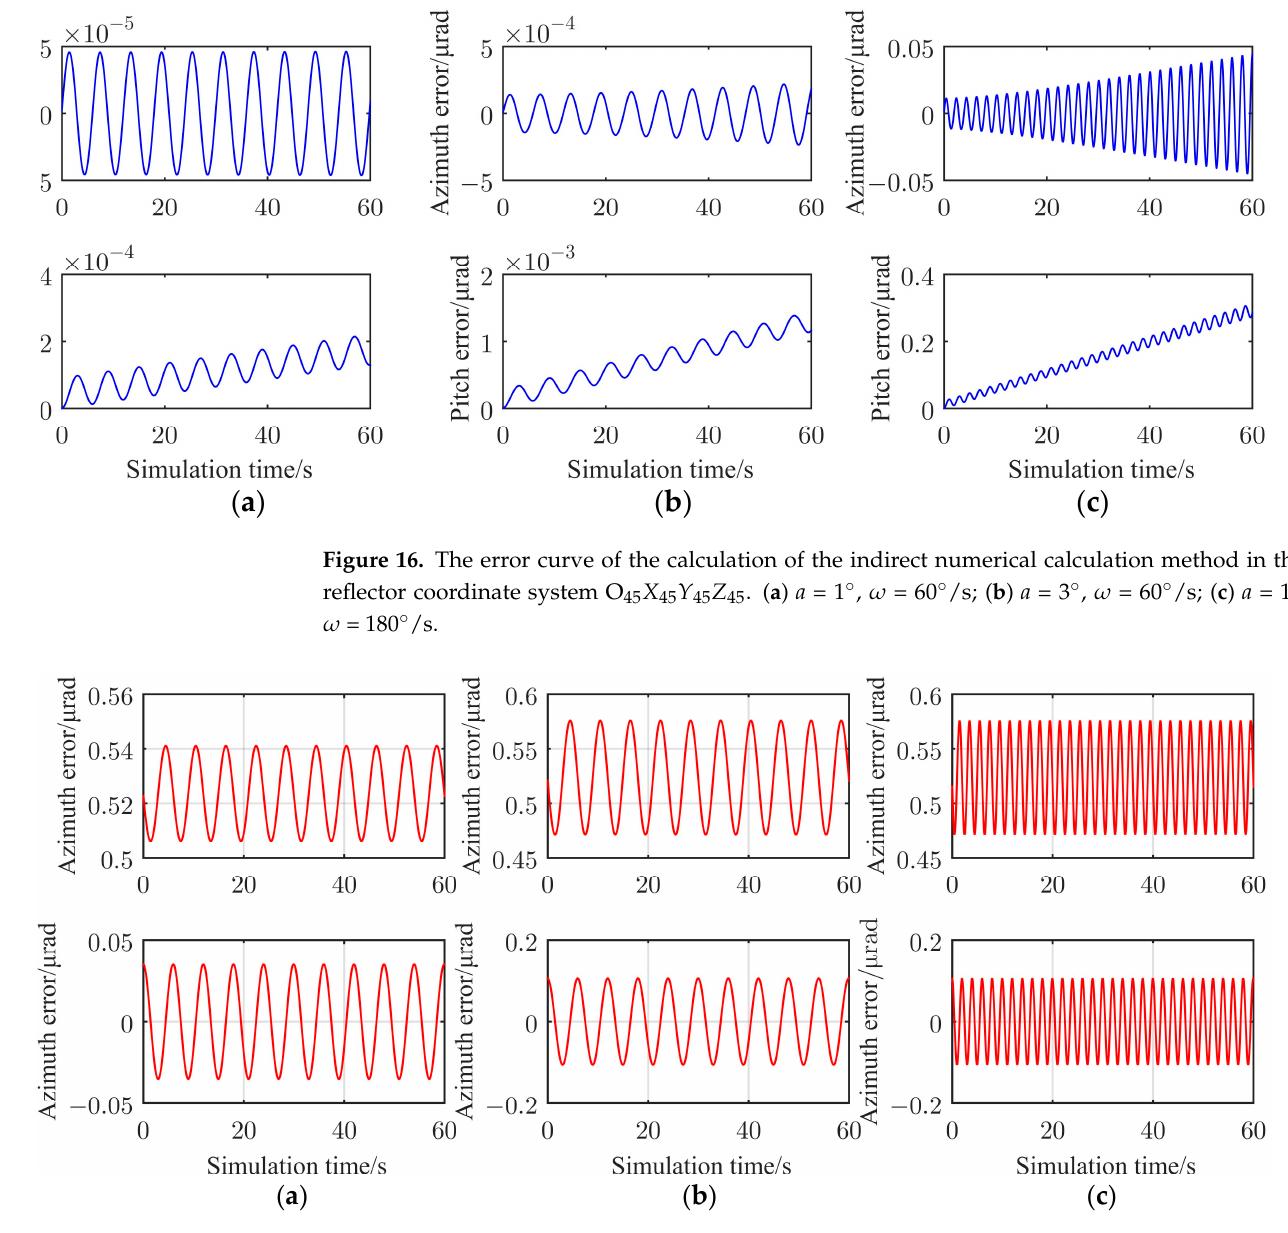
Figure 17. The LOS attitude curves under the condition of conical motion in an ideal state in the